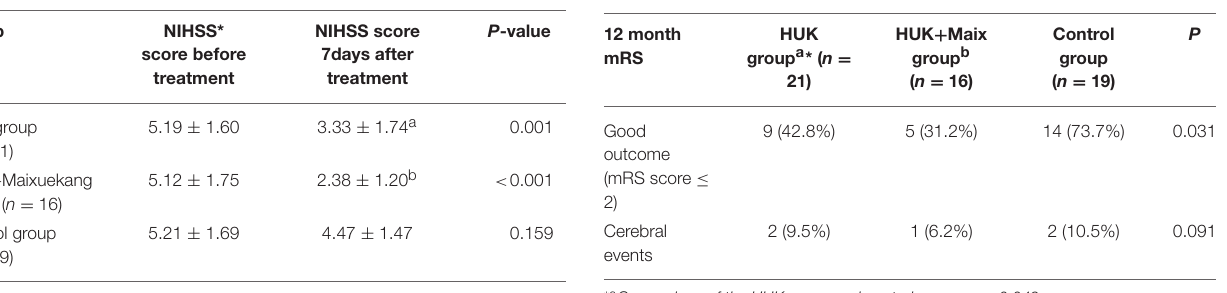
TABLE 3 | Comparison of good Functional Outcome (mRS score on) rates and incidence of acute cerebral events of three groups in 12 months after